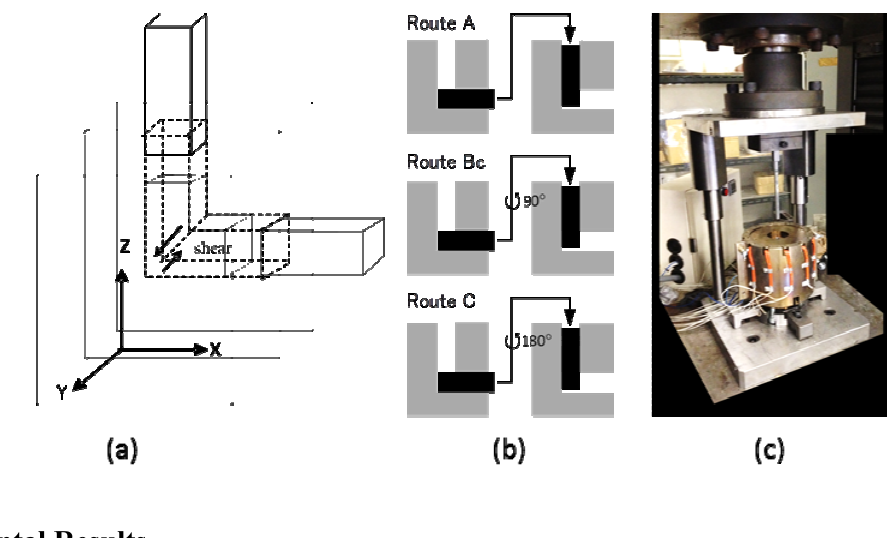
Figure 1. ( a ) Equal Channel Angular Pressing (ECAP) system; ( b ) Schema ECAP of